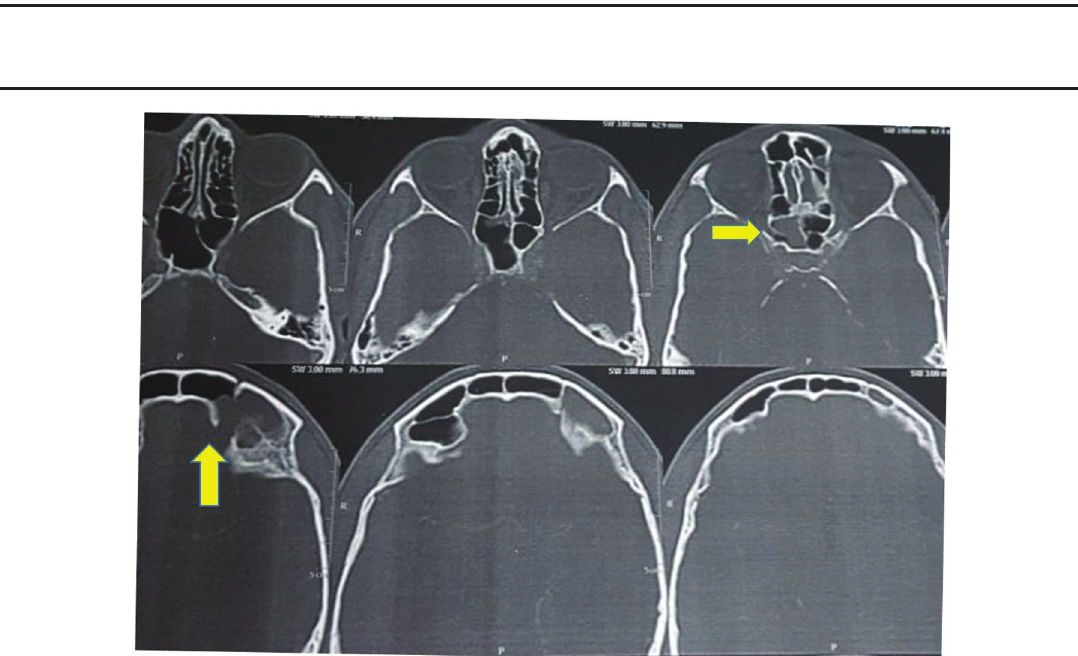
CT paranasal sinus showing right sphenoidal (horizontal arrow) and left frontal (vertical arrow) meningoencephalocele. Left frontal posterior wall disrupted at septum with supraorbital cell.